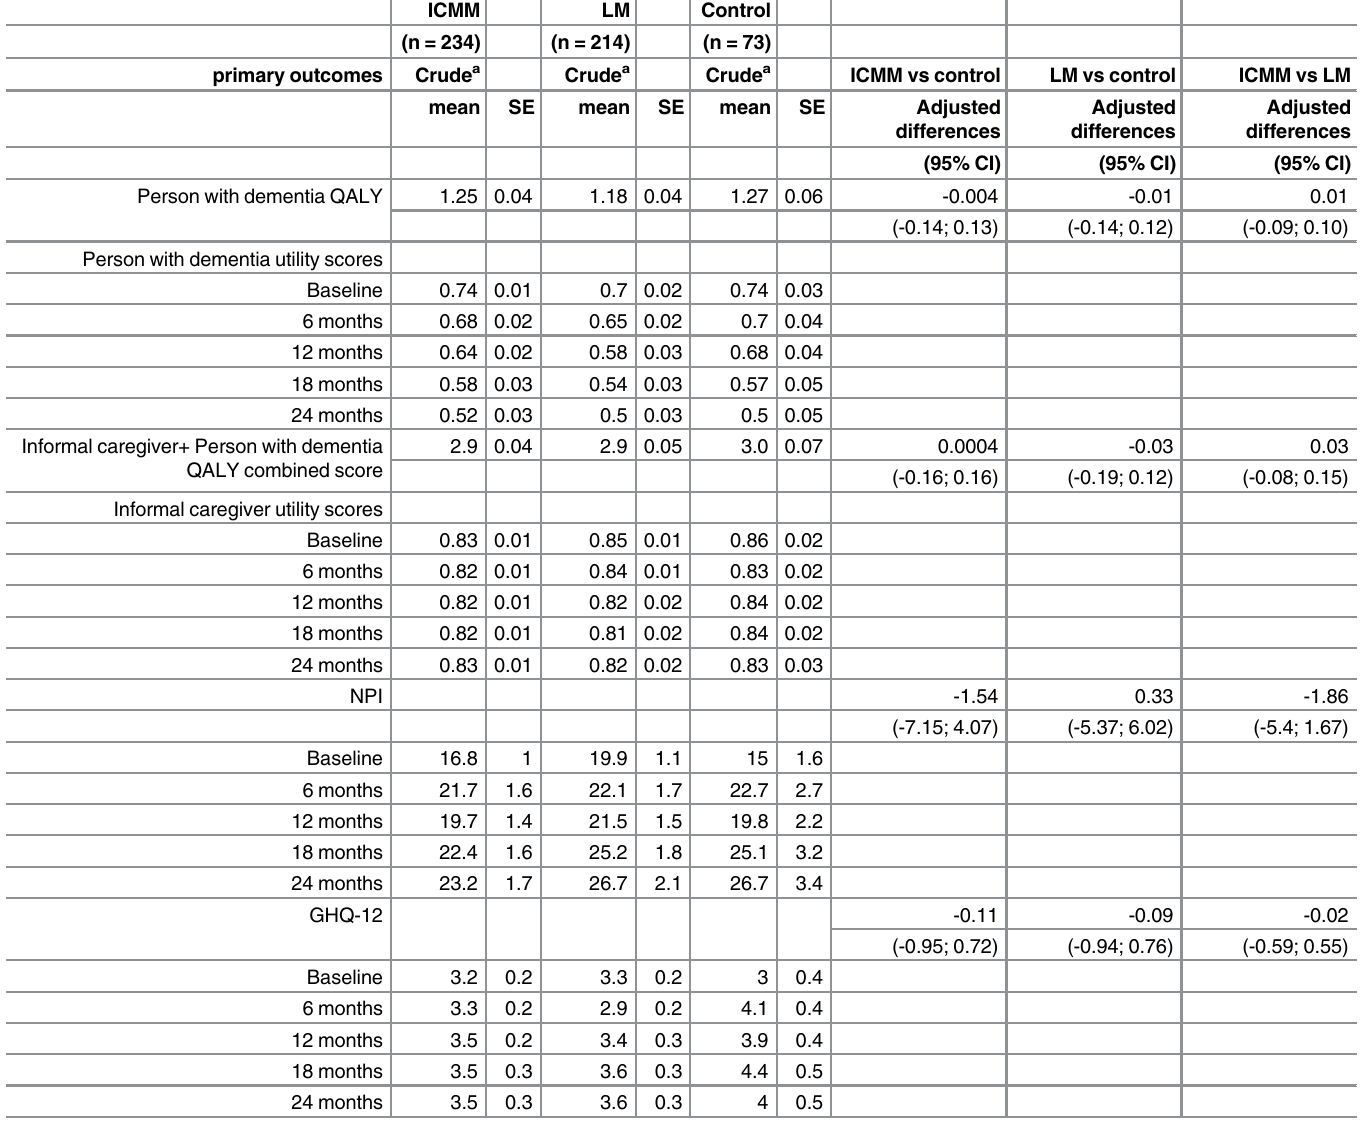
Table 2. Clinical outcomes raw mean scores and standard errors after 24